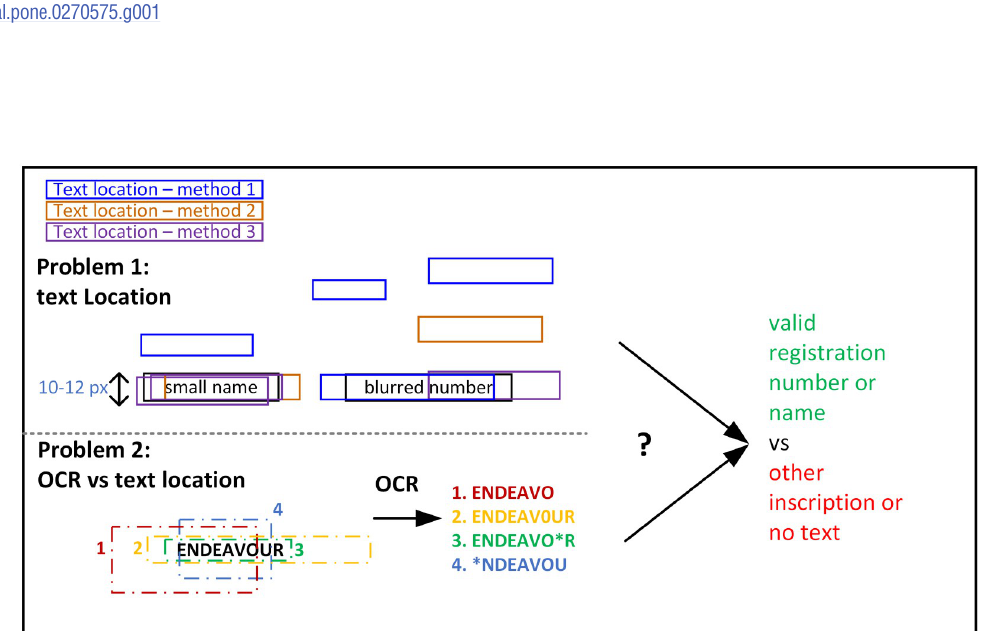
Fig 2. Illustration of the inscription recognition problem.